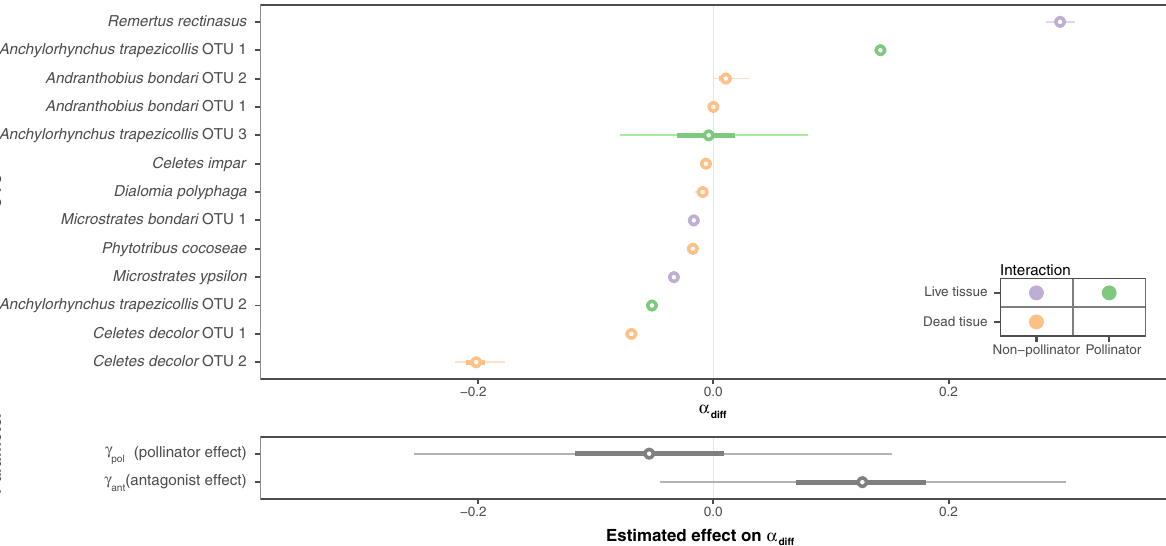
Fig. 3 Effects of insect – plant interaction on variation of α diff across OTUs. a Posterior distribution of α diff across OTUs, ordered by average α diff . b Posterior distribution of parameters associated with pollination and antagonism, when compared to non-pollinators and non-antagonists. Points: average estimates, thick lines: 50% credibility intervals, thin lines: 95% credibility